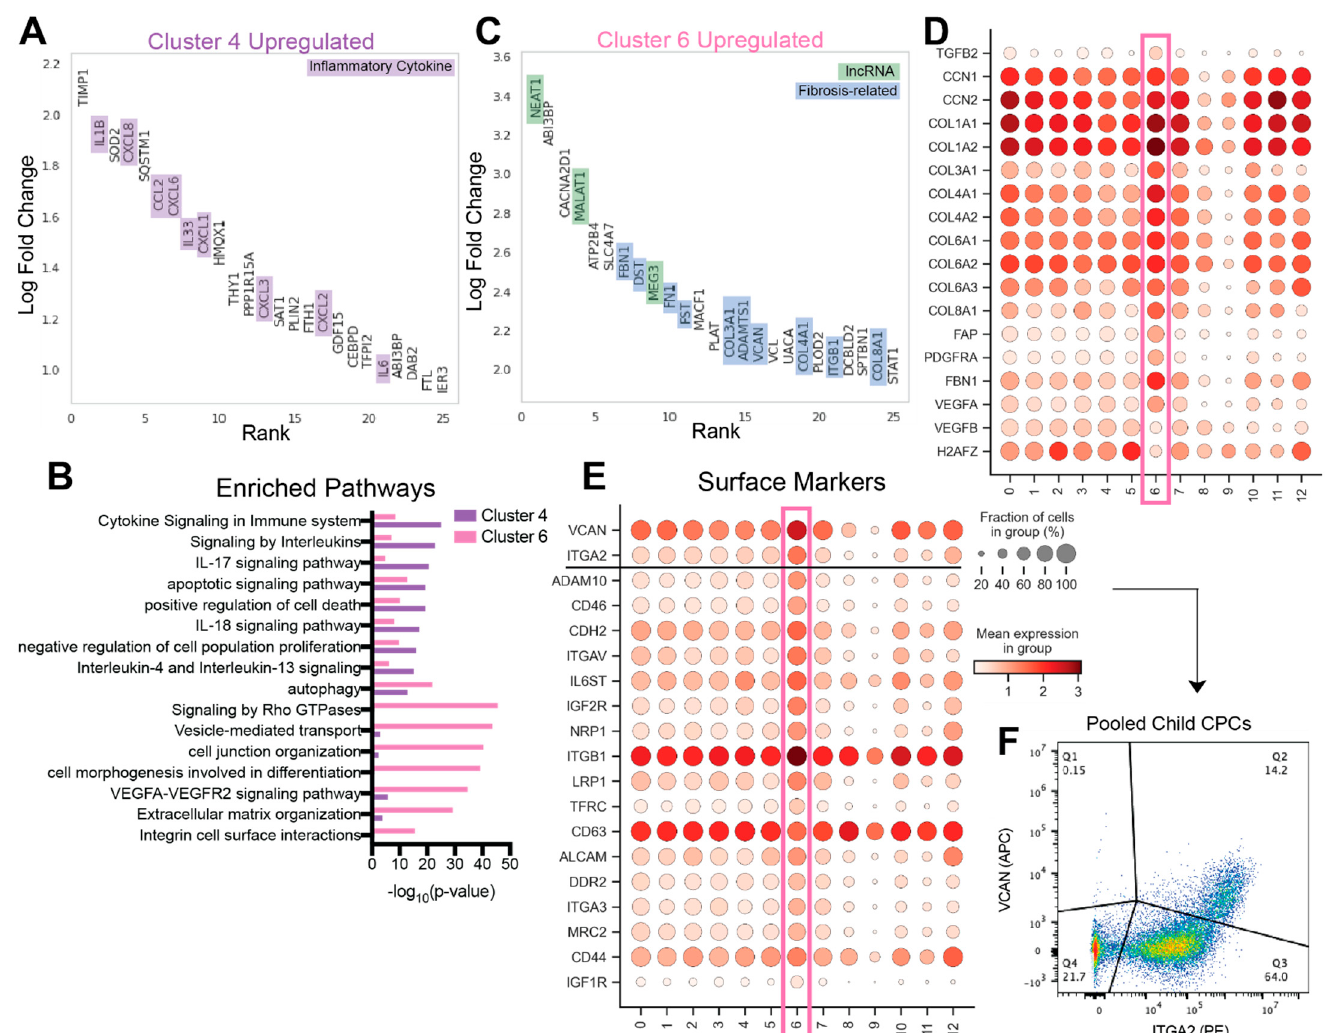
Figure 3. Characterization of inflammatory and fibrotic cell clusters 4 and 6. ( A ) Top 25 differentially expressed genes ordered by log fold change between cluster 4 cells and non-cluster 4 cells. Inflammatory cytokines are highlighted in purple. ( B ) Pathway analysis barplot of upregulated differentially expressed genes for clusters 4 and 6 cells. ( C ) Top 25 differentially expressed genes ordered by log fold change between cluster 6 cells and non-cluster 6 cells. Long non-coding RNAs (lncRNAs) are highlighted in green and fibrosis and extracellular matrix-related RNAs are highlighted in blue. ( D ) Dot plot of selected genes relating to fibrosis, angiogenesis, and proliferation. ( E ) Transcriptional expression of conserved differentially expressed surface proteins in cluster 6 cells. ( F ) Identification of a cluster 6-like population of interest in pooled child CSCs: ITGA2+,